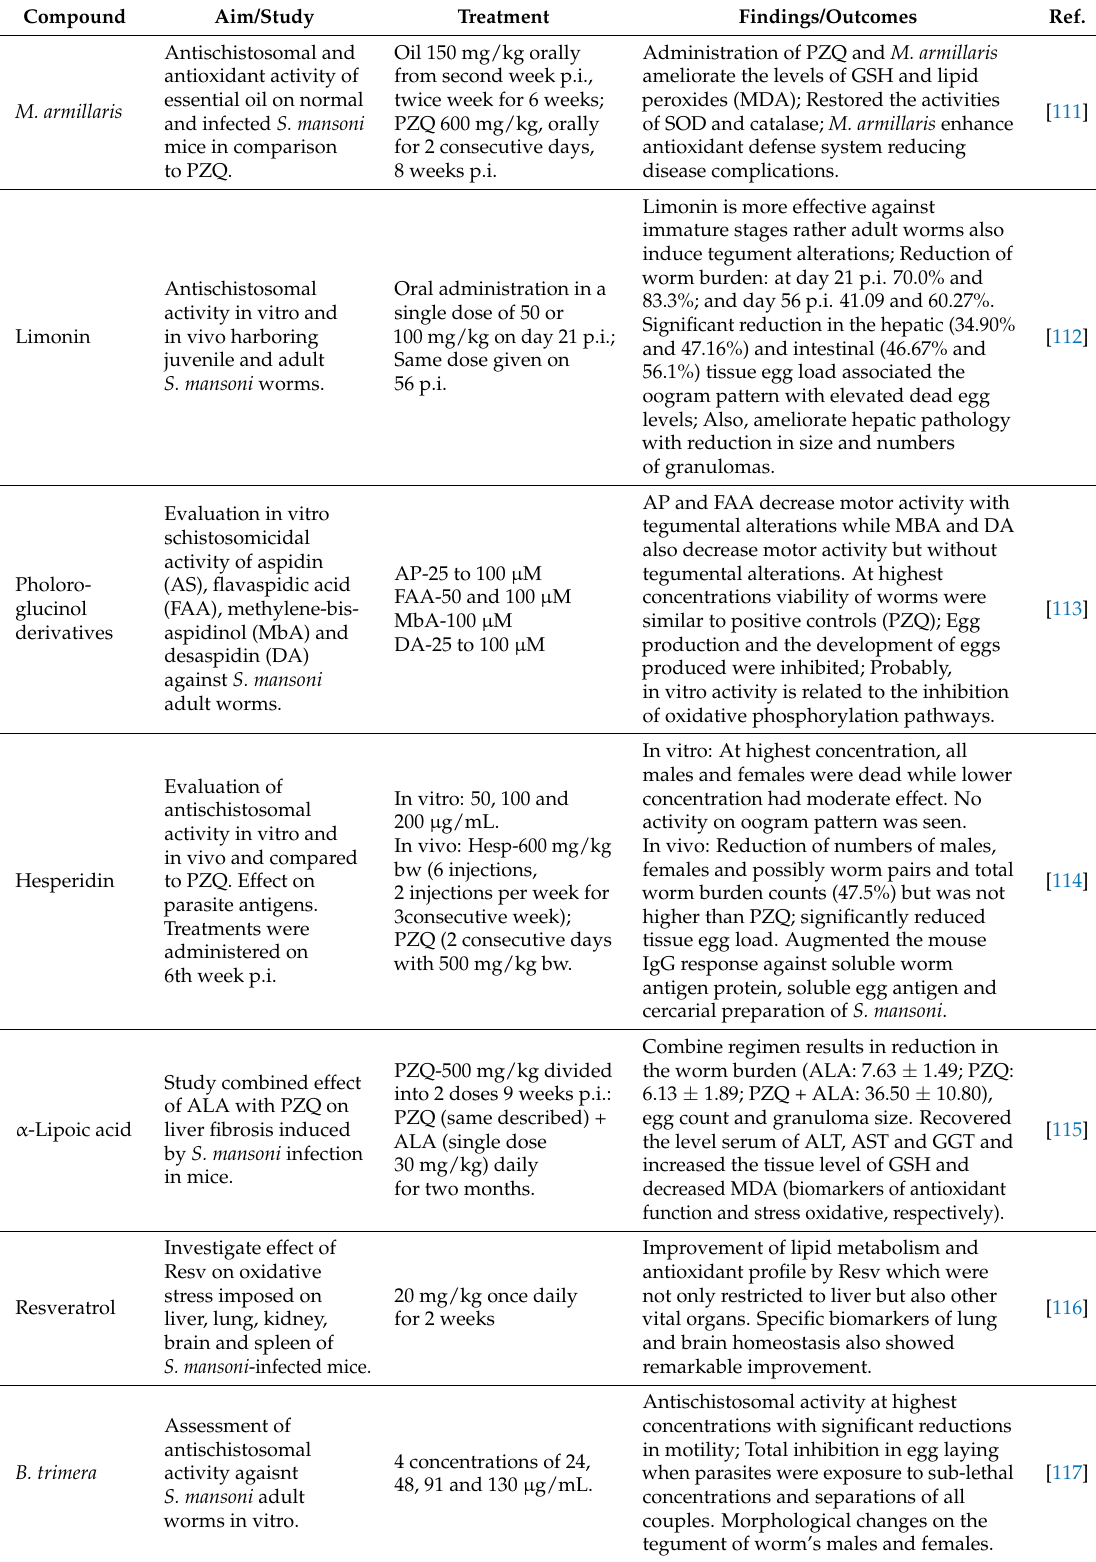
Table 1. Reports of antioxidant effects on developmental stages of schistosomes and infection in murine